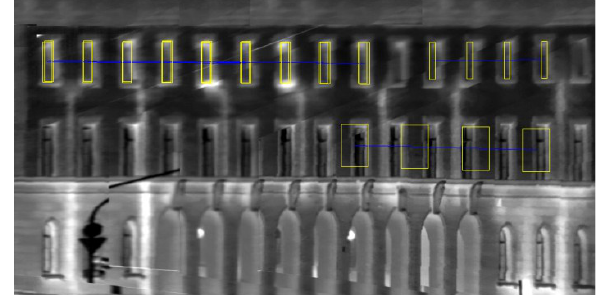
Figure 4. Result with “windows first” productions